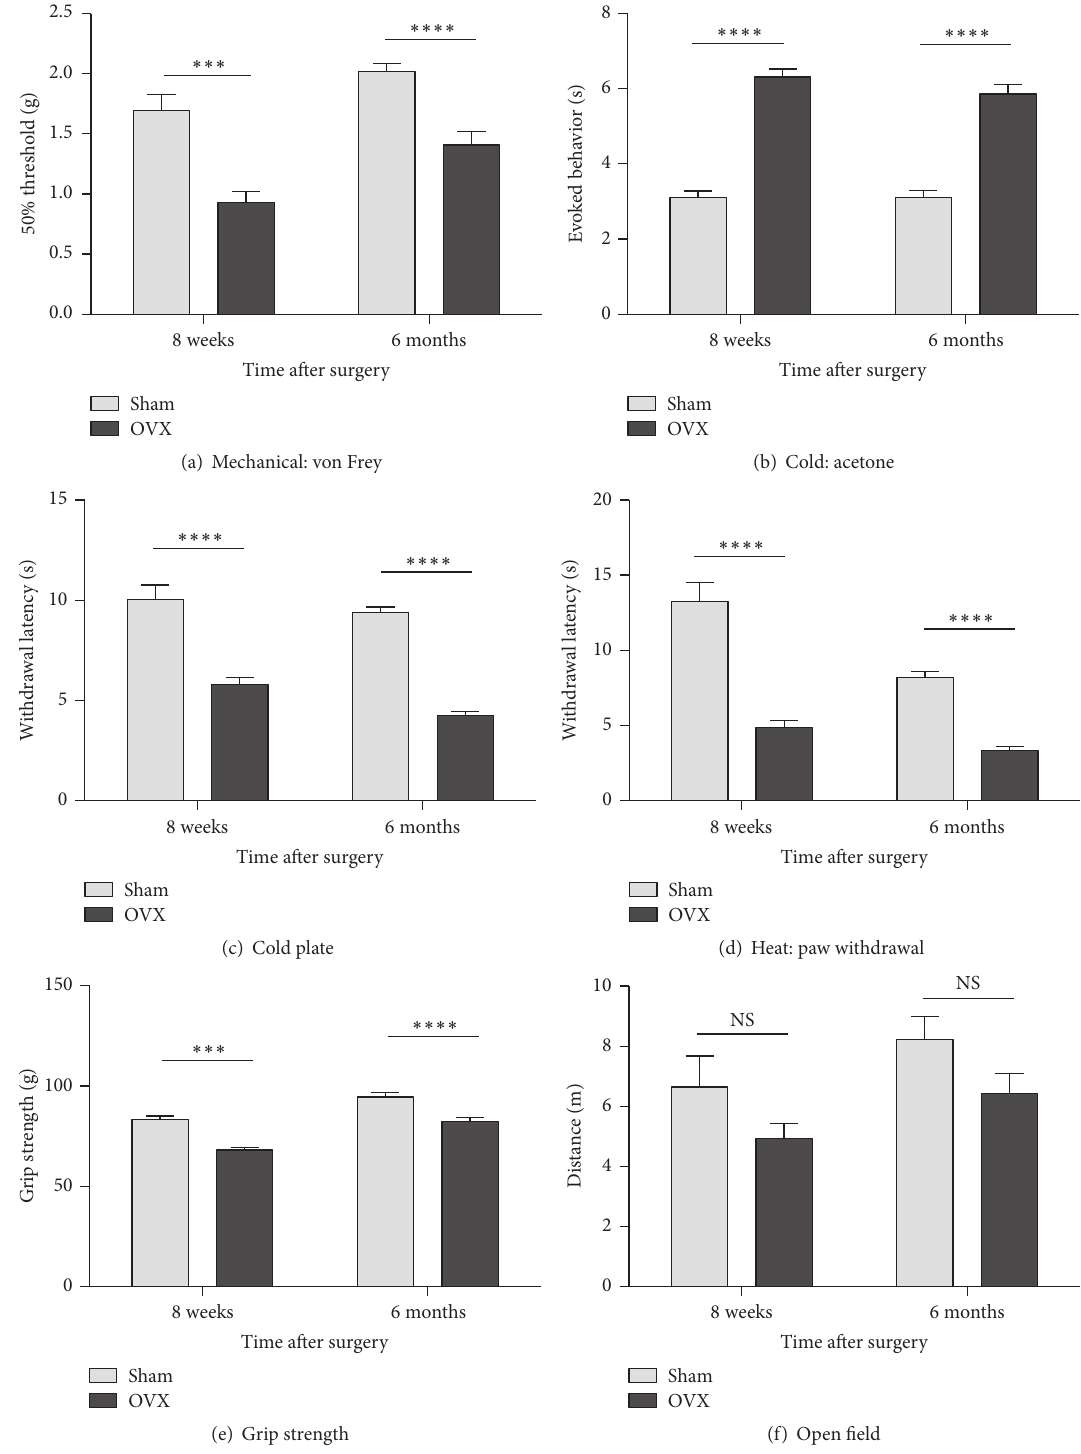
Figure 2: Effects of ovariectomy on behavioral indices of cutaneous and deep musculoskeletal pain and physical function. Hypersensitivity to cutaneous plantar mechanical stimuli (von Frey assay) (a), cold (acetone test) (b) and cold plate tests (c), and heat (radiant heat hindpaw withdrawalassay)(d)developsby8weeksandpersistsfor6monthsafterovariectomy. Usingthegripforcestrengthassayasabehavioralindex of deep musculoskeletal pain, reduced strength is observed at 8 weeks and 6 months, after surgery (e). The total exploration distance during 5-minute exposures to an open field test was used as a behavioral index of physical function; a significant difference is not evident between OVX and sham-operated mice at either time-point (f). Data are expressed as means ± standard error of the mean. OVX: ovariectomized; NS: not significant; ∗∗∗ 𝑃 < 0.001 ; ∗∗∗∗ 𝑃 < 0.0001 ; and OVX versus sham-operated, two-way repeated measures analysis of variance (factors = group × time) followed by Tukey’s test for multiple